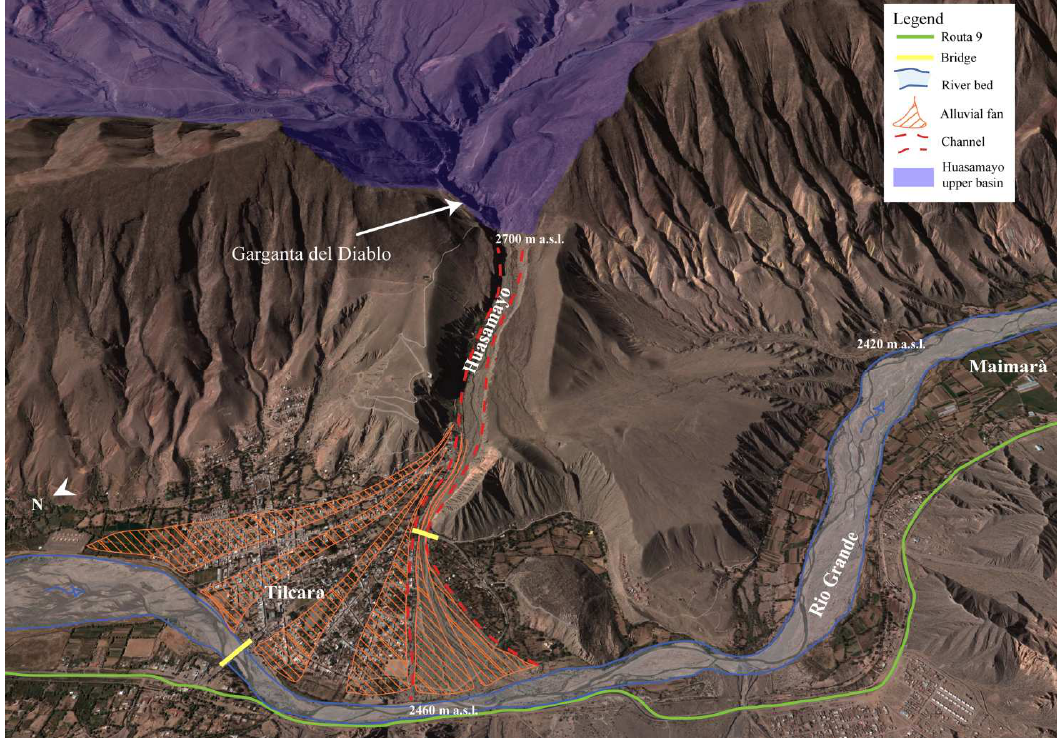
Fig. 3. The Tilcara alluvial fan. The Huasamayo Stream catchment is visible in the background. The location of Tilcara village with reference to the active depositional lobe is represented. Note the location of the National Road, which can be involved in flooding events. Image source: Google Earth